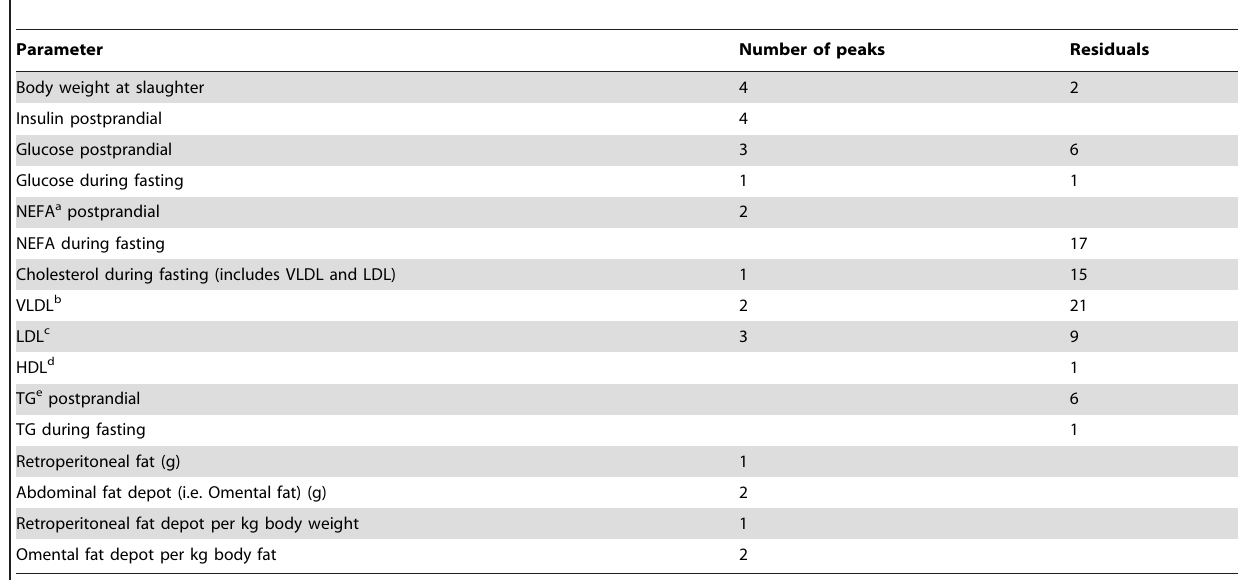
Table 5. Correlations between plasma proteome profiles and physiological parameters in control pigs fed the two diets.